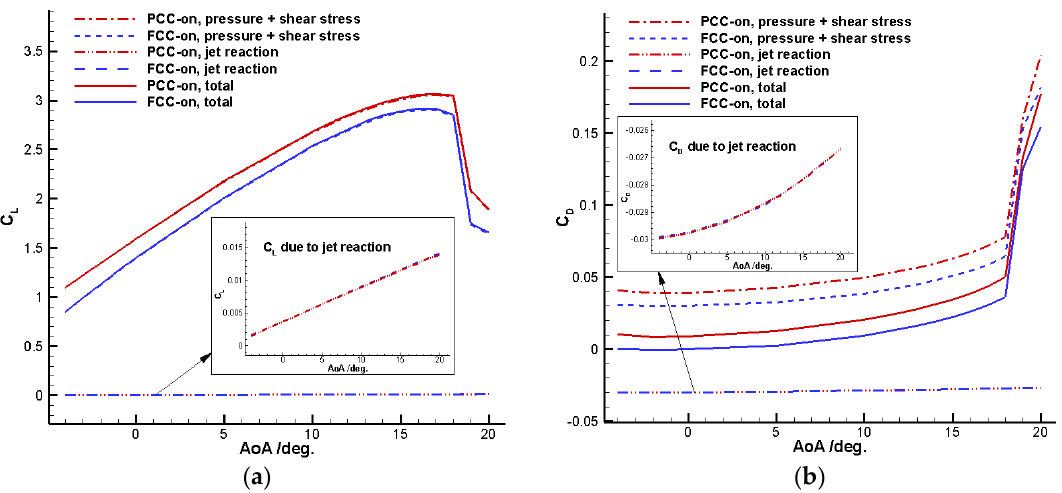
Figure 10. Decomposition of the force coefficients for PCC-on and FCC-on: ( a ) Lift coefficient; ( b ) Drag coefficient.